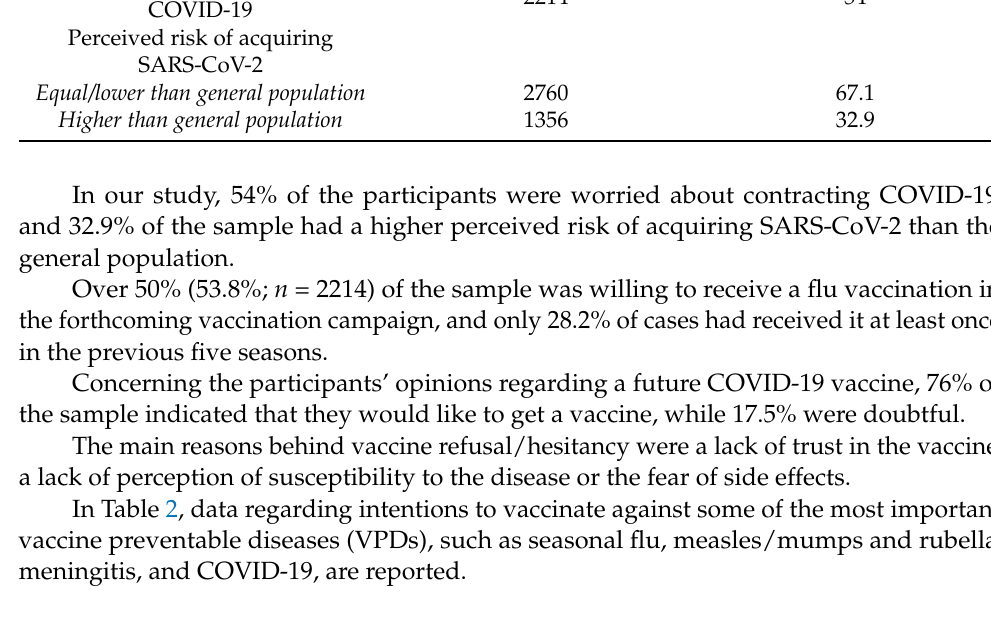
Table 2. Intention to get vaccinated against some common vaccine preventable diseases (VPDs). No I Do Not